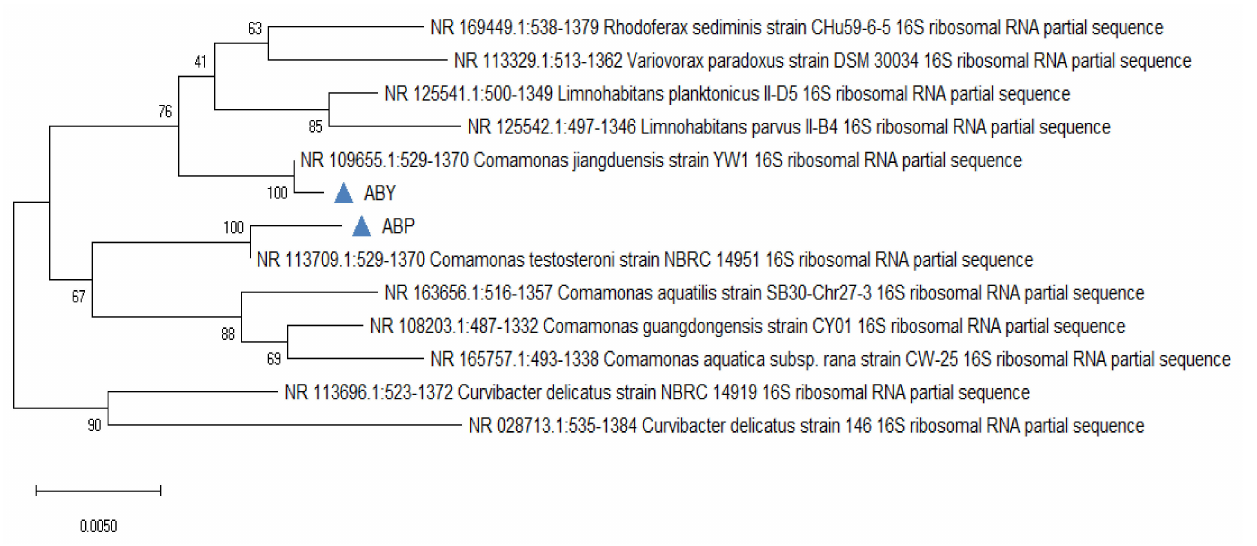
Figure 11. Phylogenetic Tree of Comamonas testosteroni (ABP) and Comamonas jiangduensis